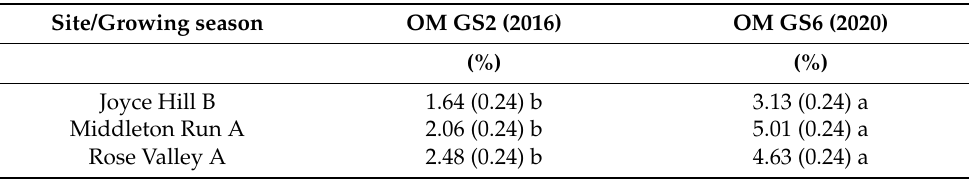
Table 2. Soil organic matter (OM) by site and growing season (GS). Values are estimated marginal means with one standard error in parentheses. Šid á k-adjusted comparisons were made among esti- mated marginal means. Growing seasons followed by the same upper-case letter are not significantly different at p < 0.05. Pairs of values of the seed mix treatment within a site followed by the same lower-case letter are not significantly different at p < 0.05.